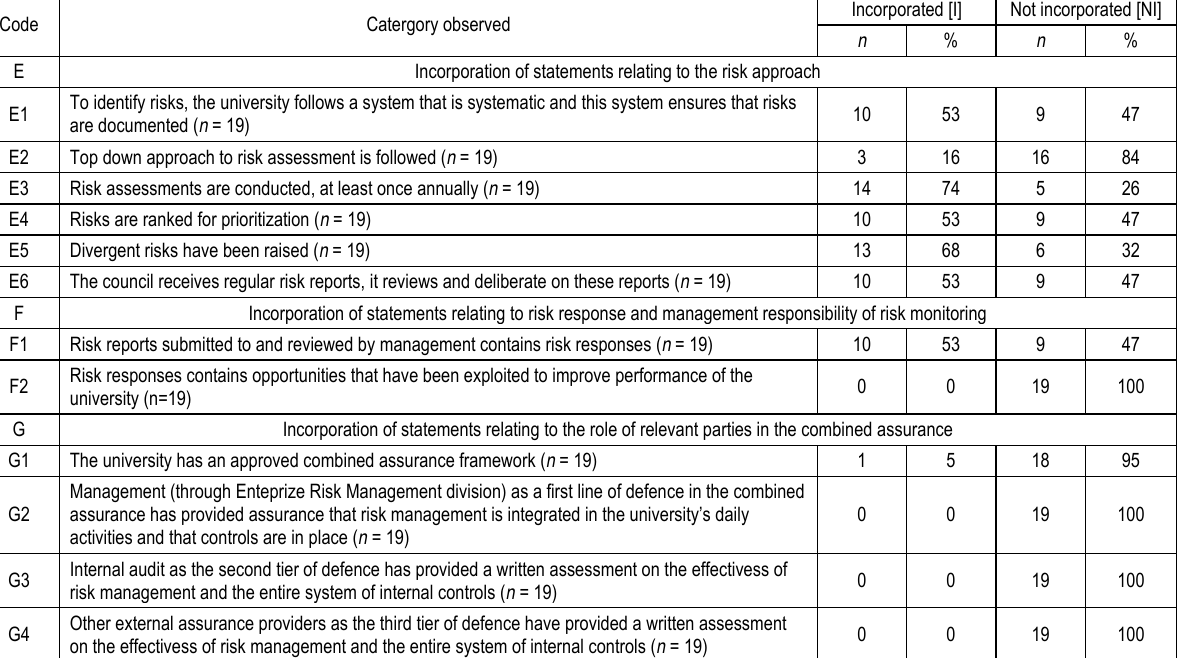
Table 3. Risk identification, assessment, risk response, risk monitoring, assurance and risk disclosure Code Catergory